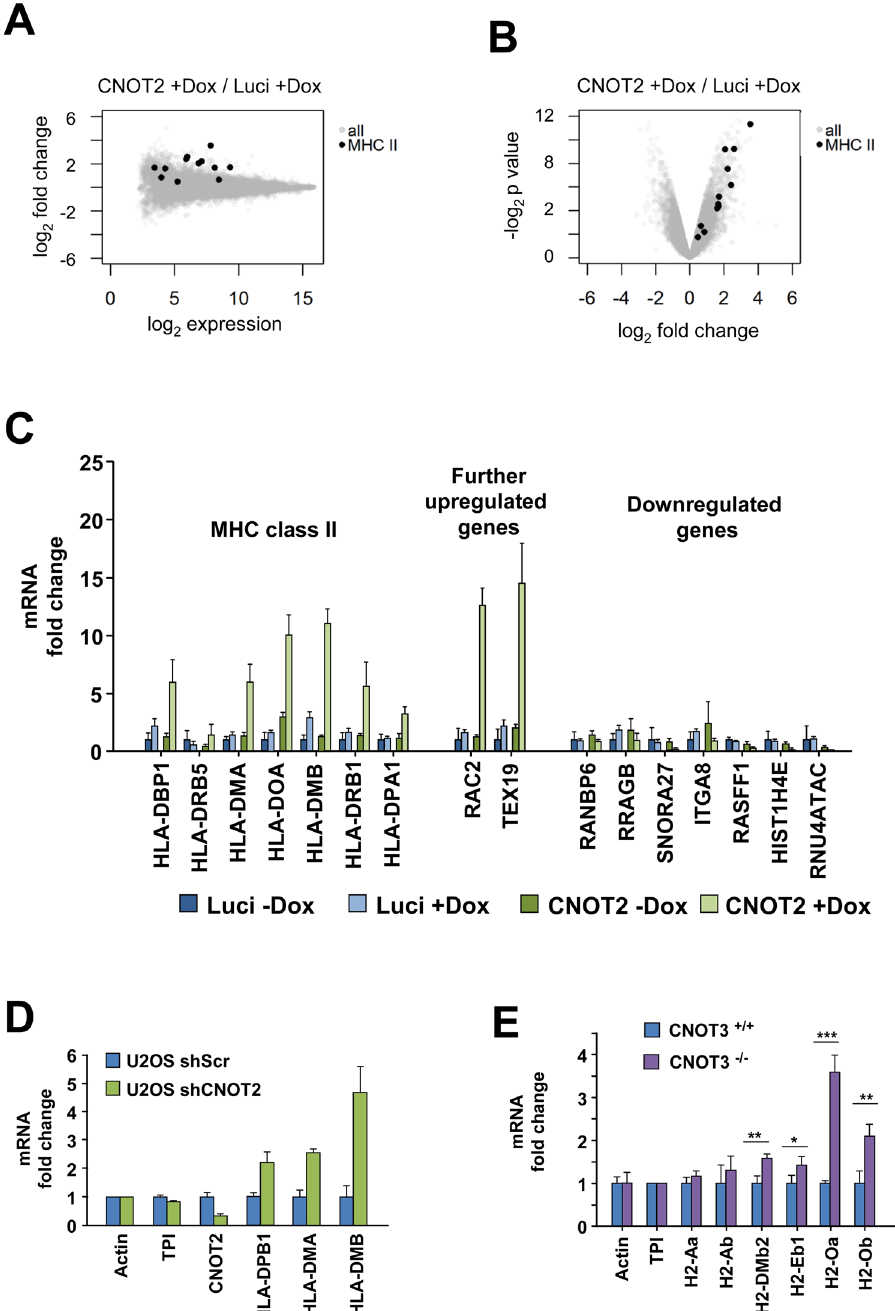
Figure 5. Analysis of CNOT2-dependent MHC II transcription. ( A ) The MA plot depicts log 2 expression versus log 2 fold change for all genes (grey) and MHC II genes (black). ( B ) The Volcano plot shows log 2 fold changes versus log 2 p-values for all genes and MHC II genes. ( C ) Human HEK-293T pIND Luci and pIND CNOT2 cells were treated for 4 days with Dox to downregulate endogenous CNOT2 and analyzed for expression of the indicated mRNA levels by RT-qPCR. All values were normalized to TPI, the gene expression in control was arbitrarily set as 1 in order to facilitate direct comparison of the data. The error bars represent the standard deviation of three biological replicates. ( D ) Human osteosarcoma U2OS cells were transfected with vectors directing the expression of a CNOT2-specific shRNAs or an unspecific control scrambled shRNA (shScr). Transfected cells were selected for two days in puromycin to eliminate untransfected cells and RT- qPCR was performed to quantitate mRNA levels of some MHC class II genes and to ensure the CNOT2 knockdown. The error bars represent the standard deviation of three biological replicates. ( E ) Mice were treated with tamoxifen to induce the knockout of CNOT3, followed by isolation of naïve macrophages from the bone marrow as specified in Materials and Methods. The mRNA levels of some MHC class II genes were determined by RT-qPCR, the error bars represent the standard deviation from three biological